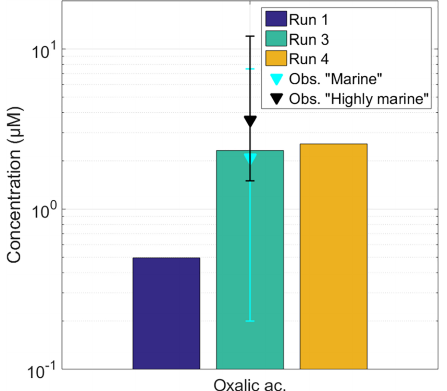
Figure 5. Averaged concentrations of oxalic acid calculated by the model during Run 1 (reference), Run 3 (increased quantities of or- ganics in the particle phase) and Run 4 (same as Run 3 but with for- mation of iron-oxalate complexes turned off). Concentrations mea- sured in marine and highly marine clouds sampled at Puy de Dôme (Deguillaume et al., 2014) are reported for comparison. Markers represent the mean concentrations, while lower and upper limits of the error bars respectively show the minimum and maximum con- centrations measured at this